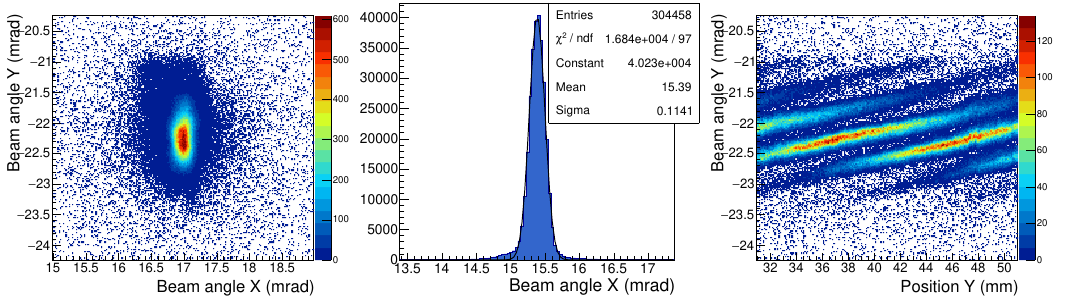
Figure 15 . Left: angular distribution of proton tracks. The angular range is (cid:6) 2 mrad. Middle: X projection. The sigma of distribution is 110 µ rad. Right: beam angle Y as a function of Y coordi- nate. Each line corresponds to the exposure with a given Y coordinate. The positive correlation with position Y (slope of 0.44 mrad/cm) demonstrates the beam divergence.